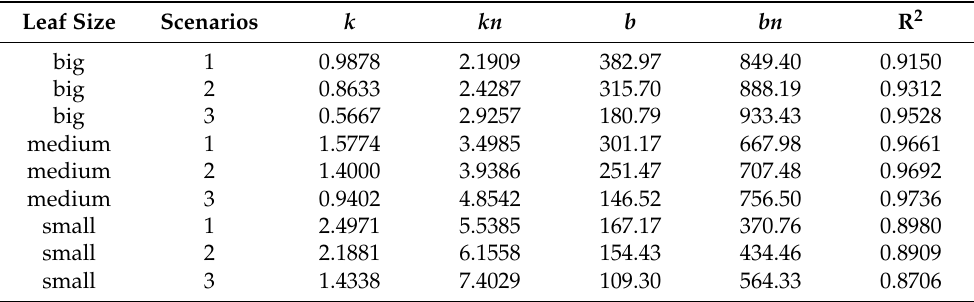
Table 2. The parameters of the fitted equation ( y = kx + b , x = leaf area, y = light interception). The slopes ( k for s1, s2, and s3 and kn for sn1, sn2, and sn3) and intercepts ( b for s1, s2, and s3 and bn for sn1, sn2, and sn3) of a total of 18 combinations were displayed with 4 decimals. The R 2 ’s were indicated in the last